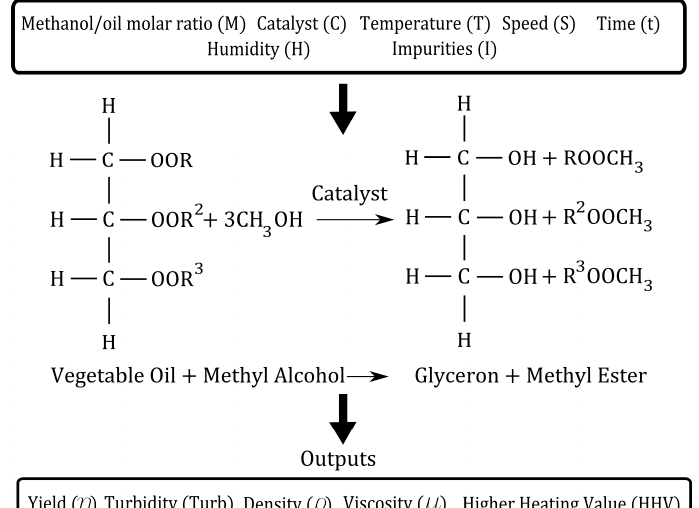
Figure 1. Properties and attributes of the transesterification process in Biodiesel production.